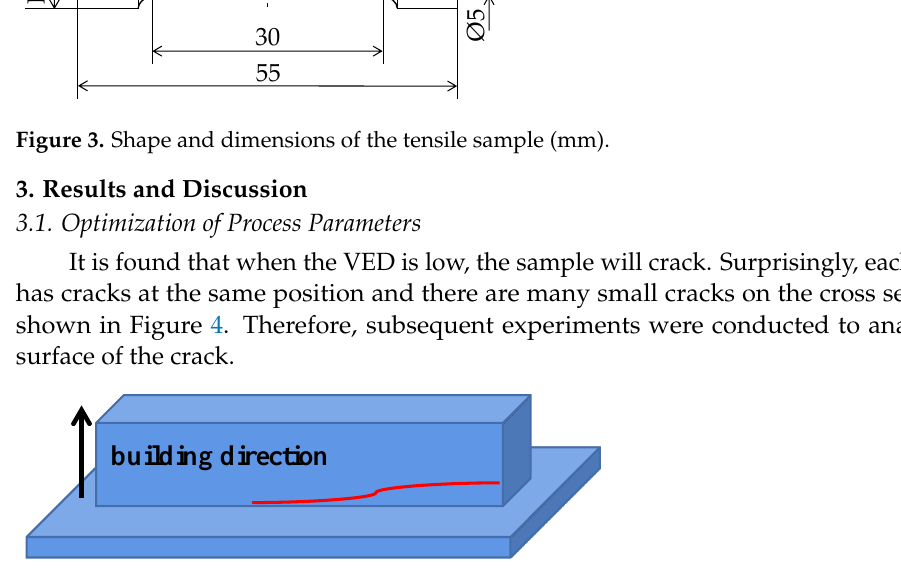
Figure 4. Schematic diagram of crack location (Red curve represents the location of major cracks).